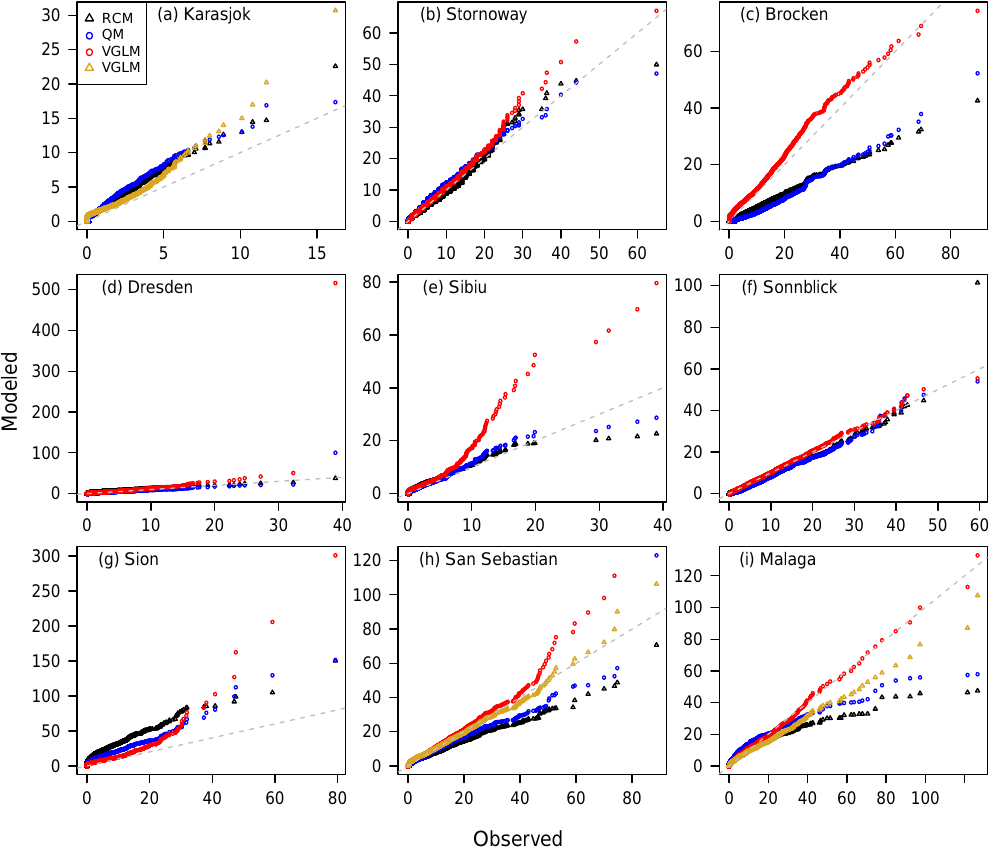
Figure 10. QQ plots for example stations of different models (cross-validated) against station observations for DJF (mmday − 1 ). (a) Karasjok, (b) Stornoway, (c) Brocken, (d) Dresden, (e) Sibiu, (f) Sonnblick, (g) Sion, (h) San Sebastian, and (i) Malaga. For the VGLM the quantiles (i.e., sorted time series) of 100 realizations are averaged. Predictor for VGLM as selected by the CvM criterion: (red circles) QM grid bias- corrected RCM; (brown triangles) uncorrected RCM. For examples to illustrate model performance and predictor selection (San Sebastian and Malaga), the VGLM is plotted for both predictors. Selected predictor: San Sebastian: RCM; Malaga: QM grid .